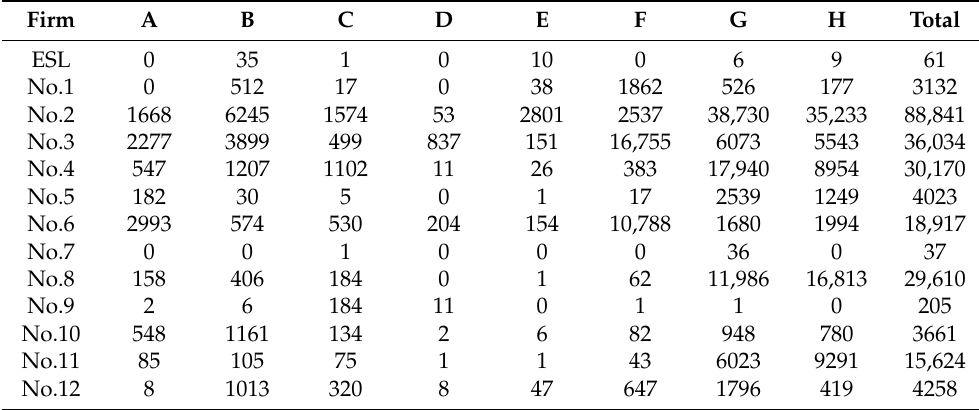
Table 3. Patents of ESL and 12 related firms under the 1st-level classification.